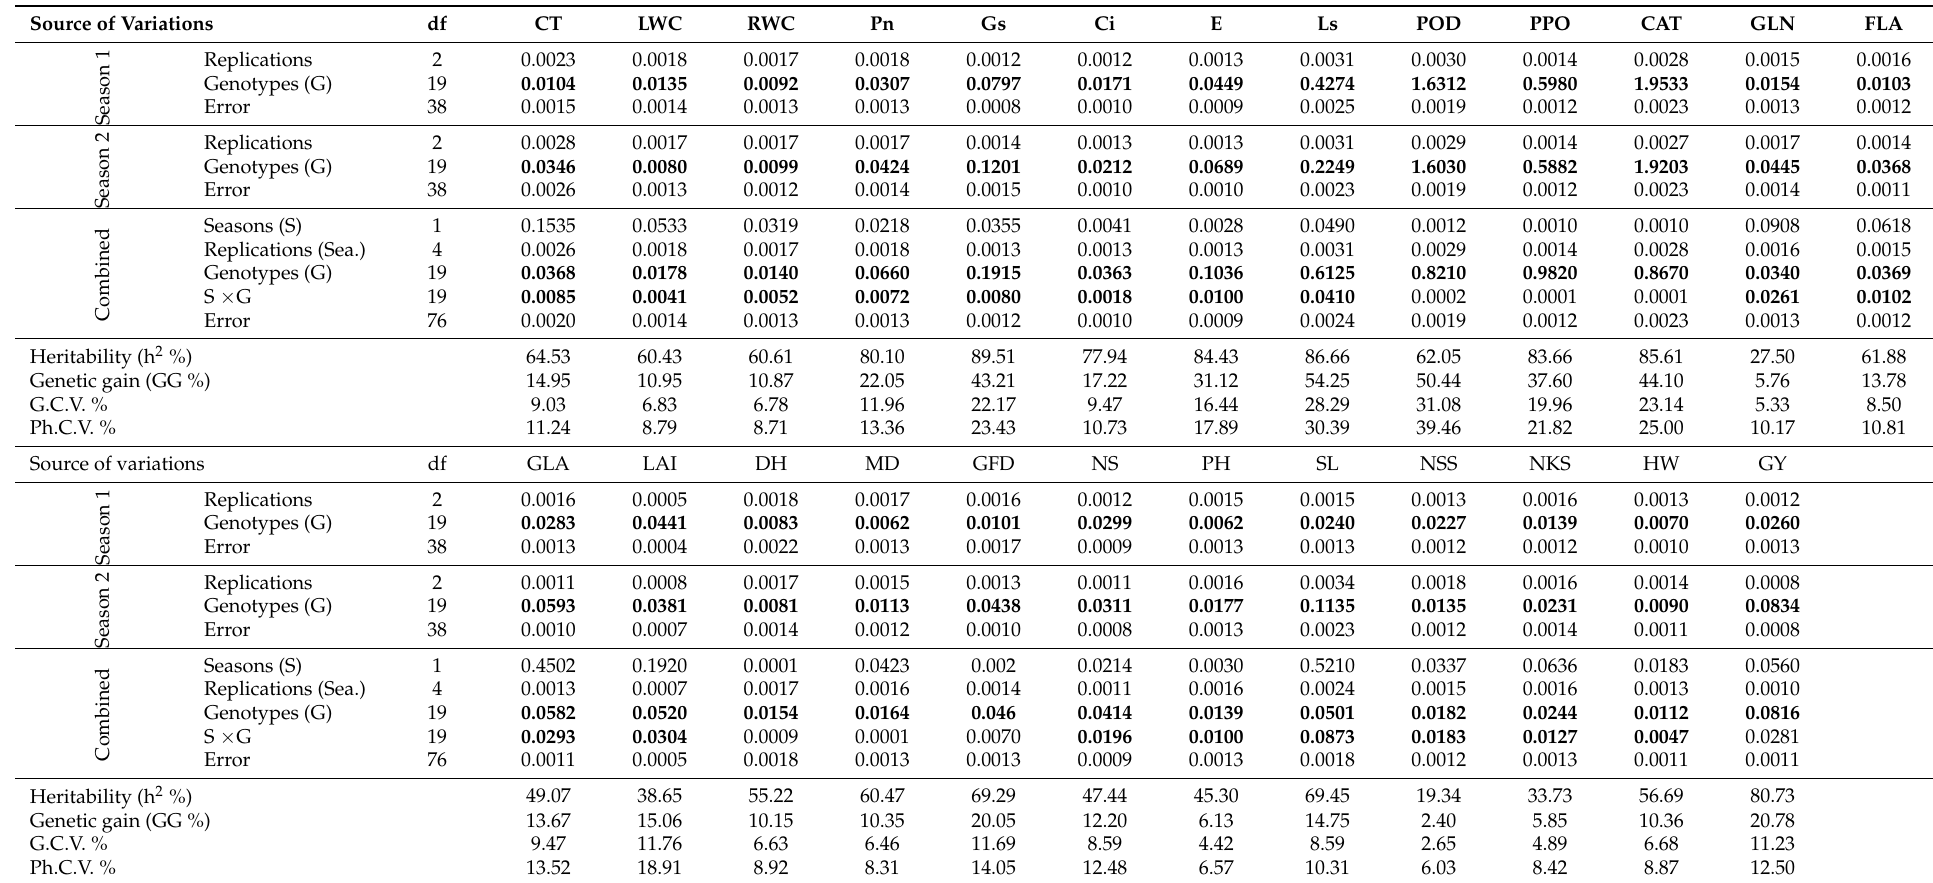
Table 1. Analysis of variance for heat tolerance index of measured traits, heritability, genetic gain, genotypic, and phenotypic coefficients of variability for traits of 20 wheat